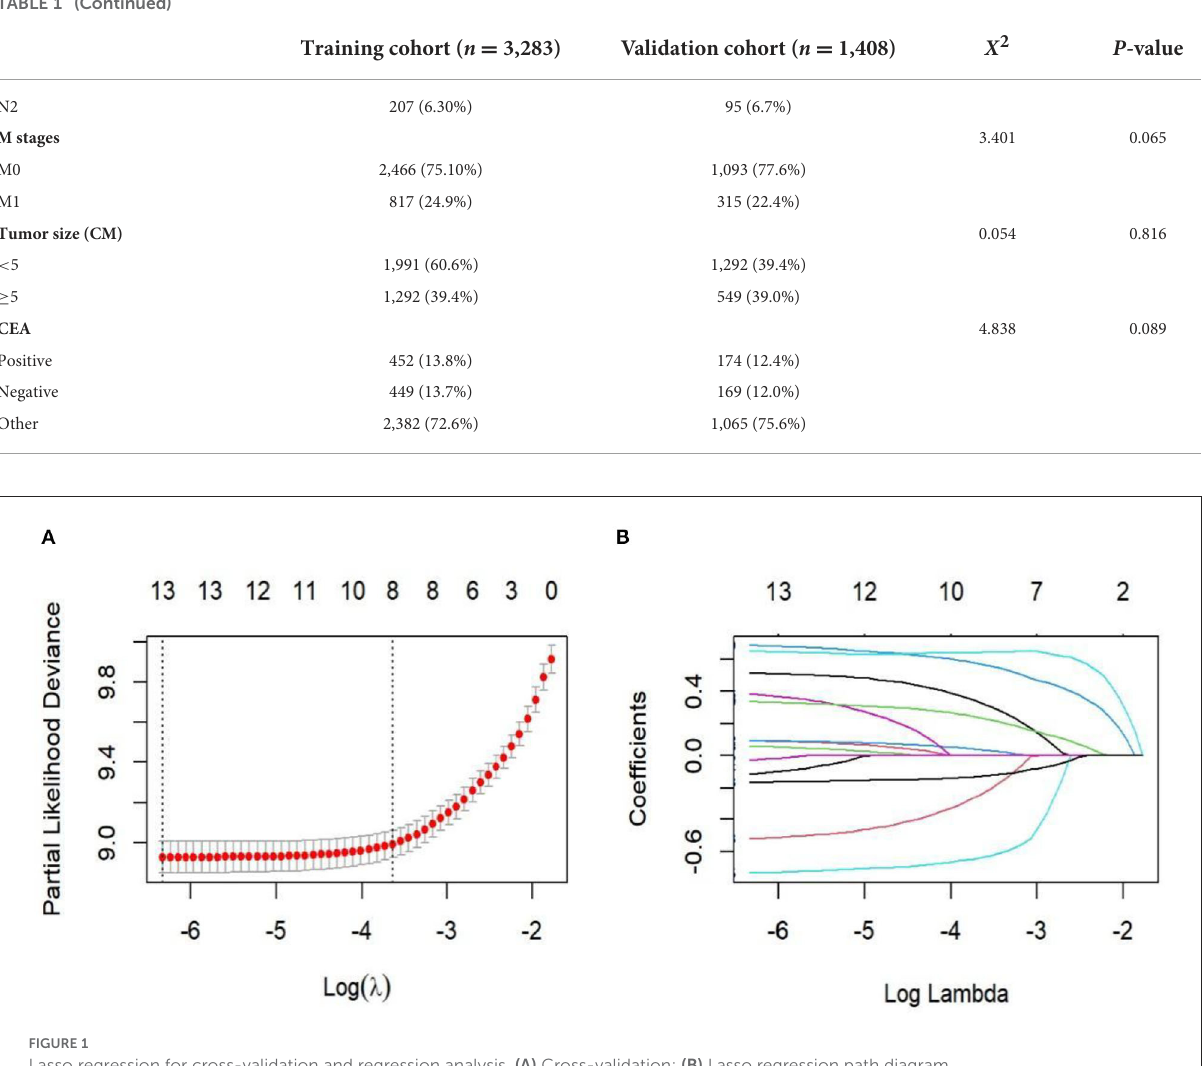
M stage, tumor size, and CEA were found to not be significantly different ( p > 0.05), as shown in Table